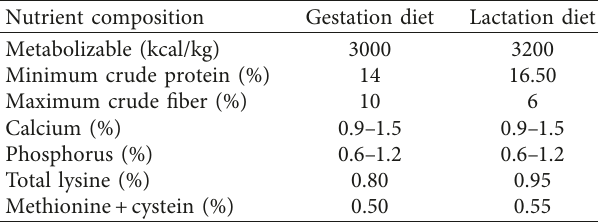
Table 1: Nutrient composition of basal diets. Nutrient